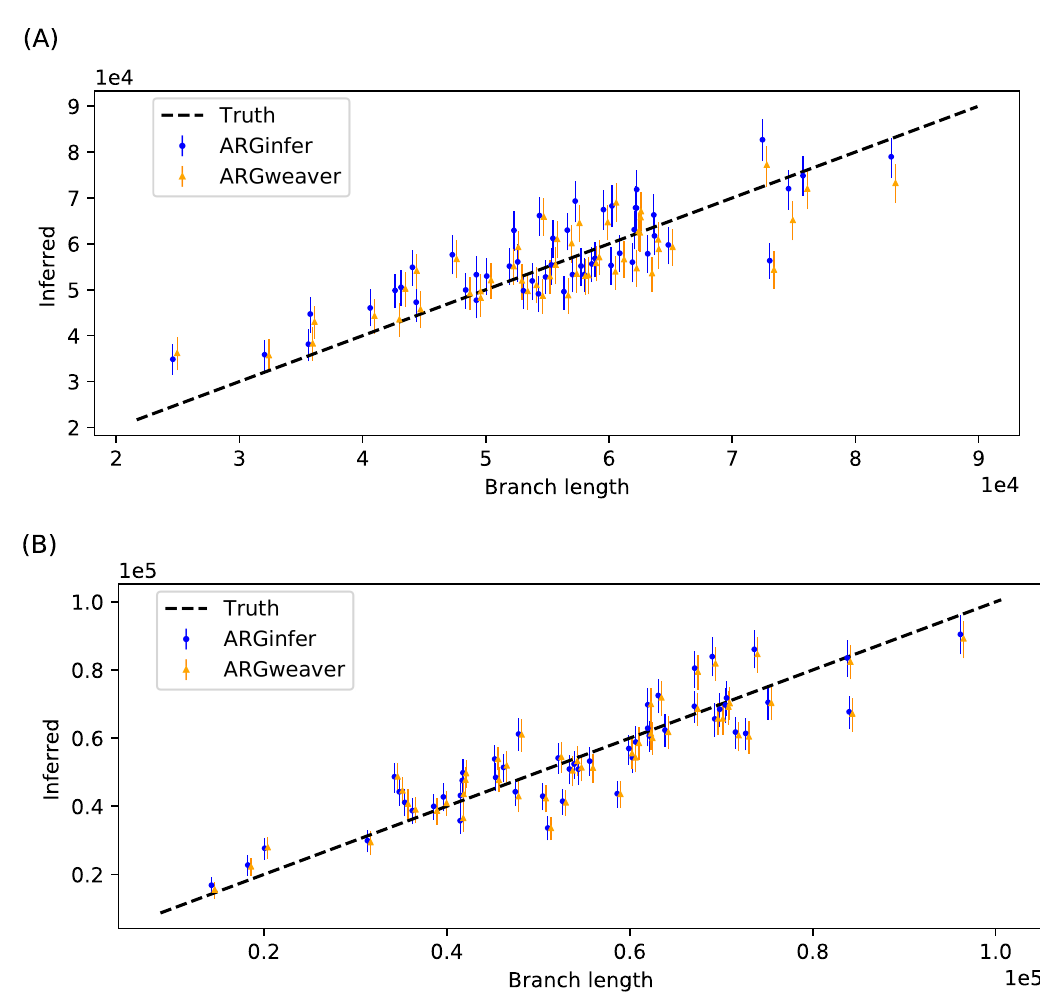
Fig 2. Posterior mean and 50% equal-tailed intervals for the total branch length, measured in generations and averaged over the 10 5 sites, inferred by ARGinfer and ARGweaver in 50 randomly-chosen data sets. (A) R = 1 and (B) R =